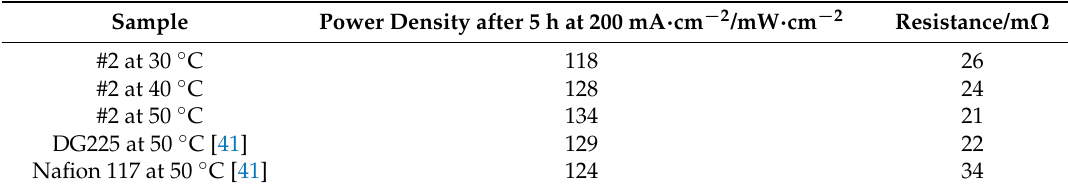
Table 1. Performance and the resistance of the PEM in the fuel cell test.